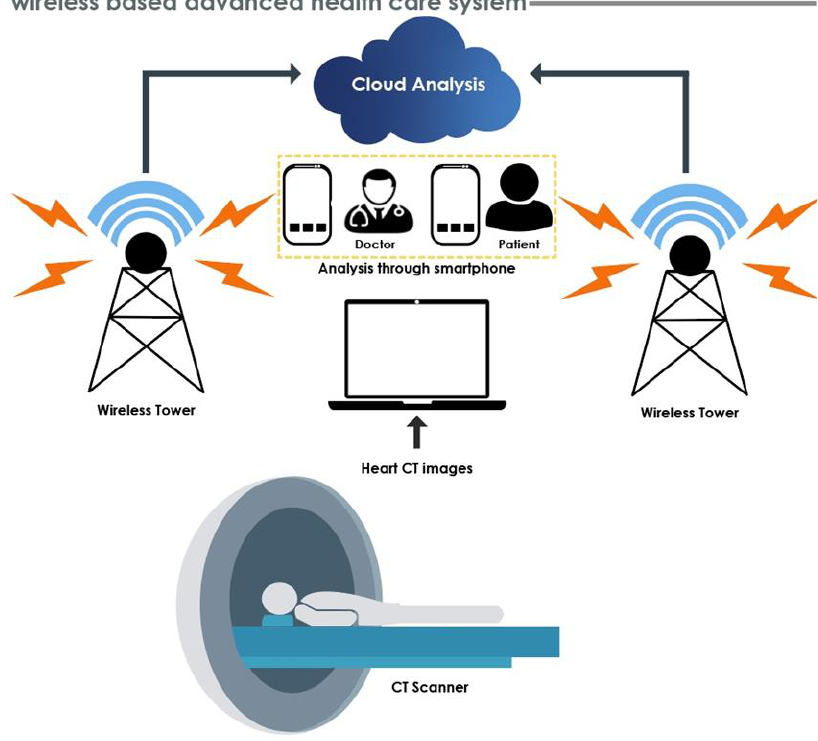
Figure 5. Future healthcare system using wireless